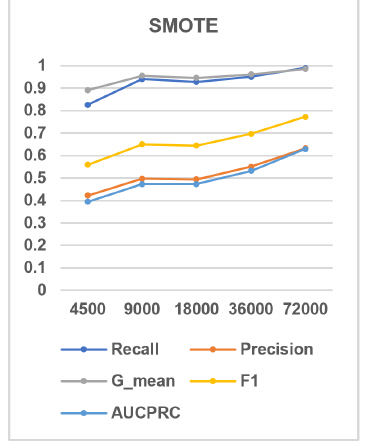
Figure 25. SMOTE: Impact of Dataset Size